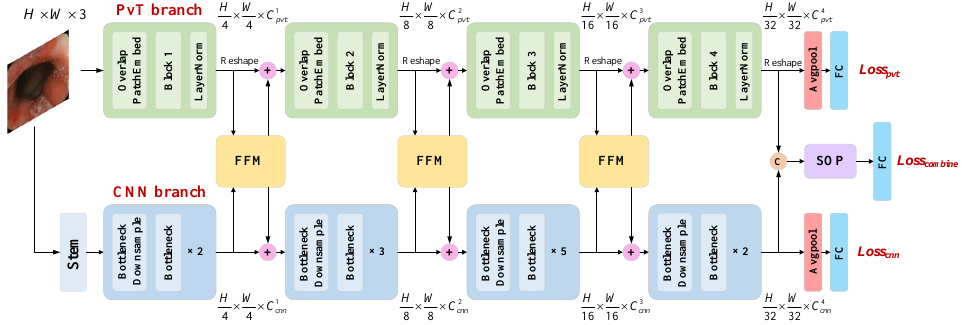
Figure 2. Illustration of the pyramid hybrid feature fusion framework (PHF 3 ). The stem consists of a convolution, a batch normalization, a ReLU activation function, and maximum pooling; FFM: feature fusion module, SOP: second-order pooling, LayerNorm: layer normalization, FC: fully connected